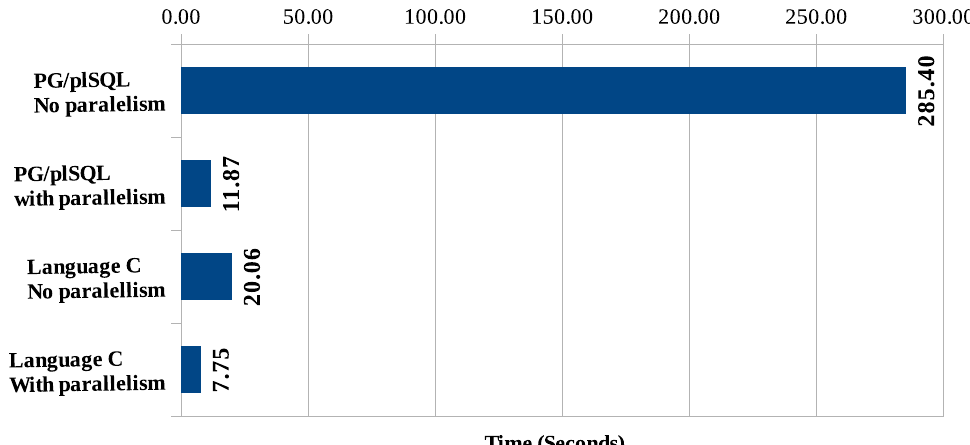
Figure 19. Lowest processing time by